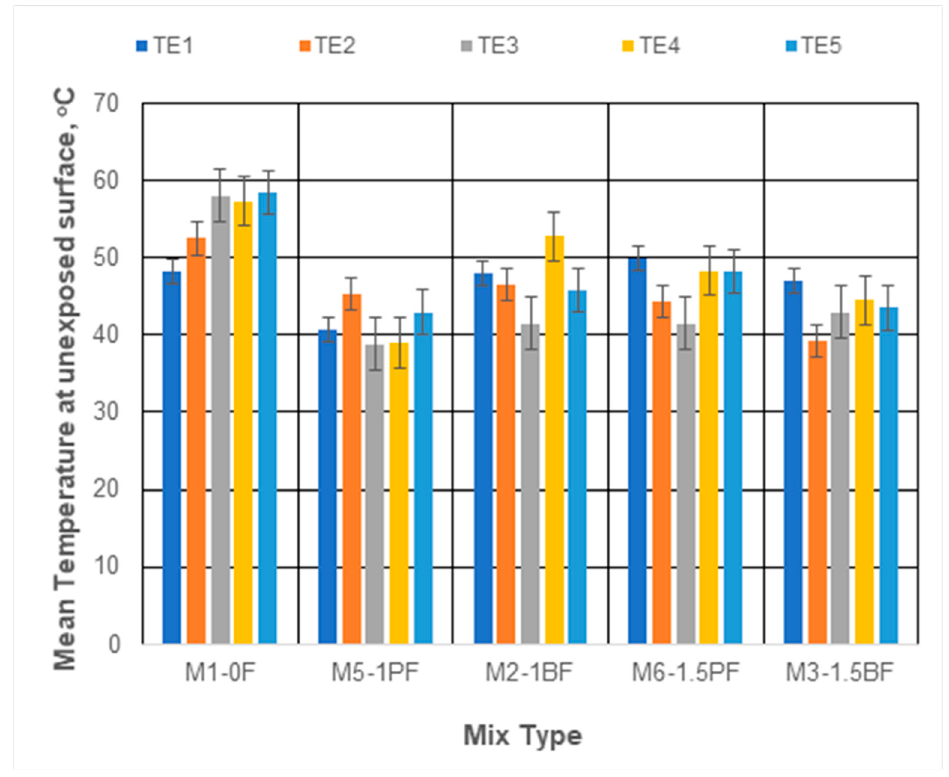
Figure 7. The temperature of external thermocouples measured at 120 min of fire exposure (at the unexposed surface).